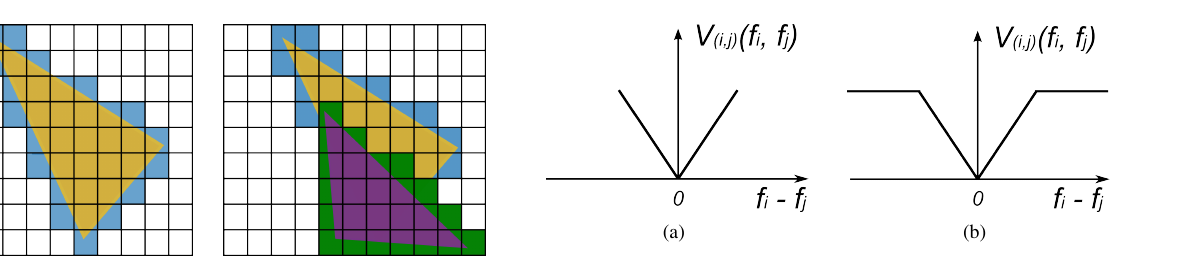
Figure 4. Different types of pairwise regularization terms. (a) The linear regularization function without truncation constant (T =